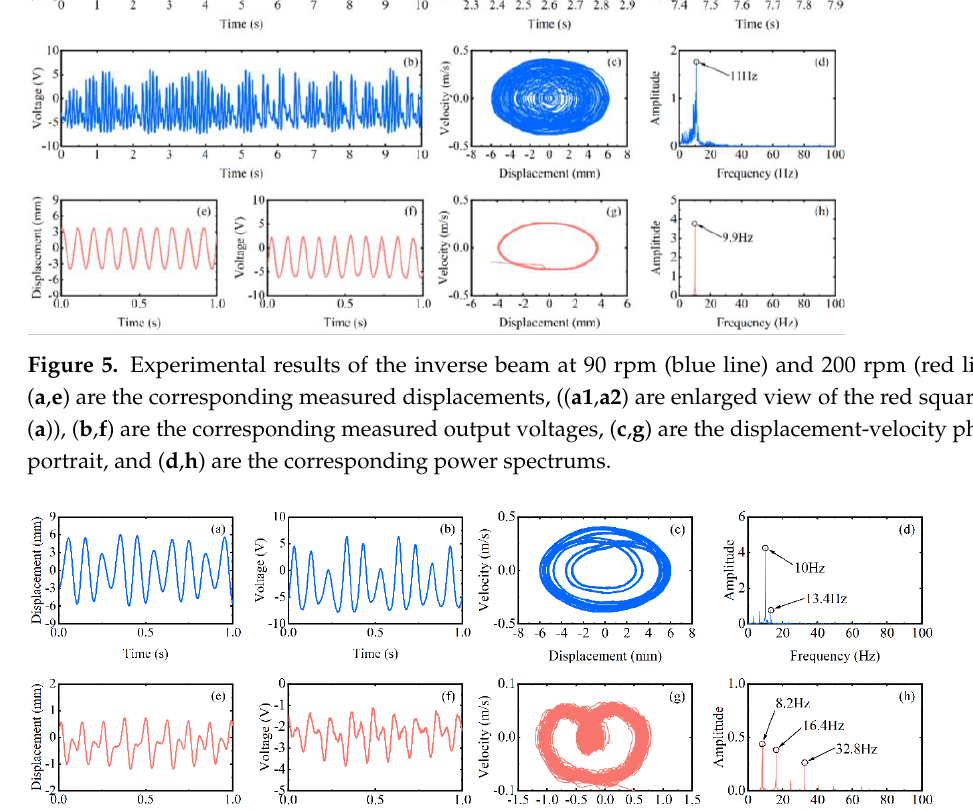
Figure 6. Experimental results of the inverse beam at 270 rpm (blue line) and 330 rpm (red line), ( a , e ) are the corresponding measured displacements, ( b , f ) are the corresponding measured output voltages, ( c , g ) are the displacement-velocity phase portrait, and ( d , h ) are the corresponding power spectrums.